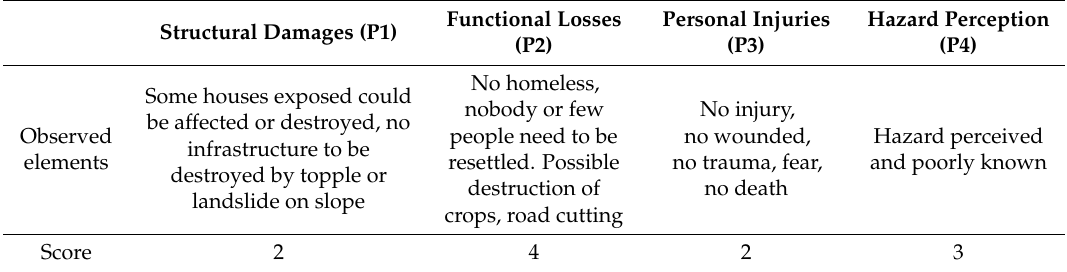
Table 6. Severity assessment of the lake Nyos landslide hazards.